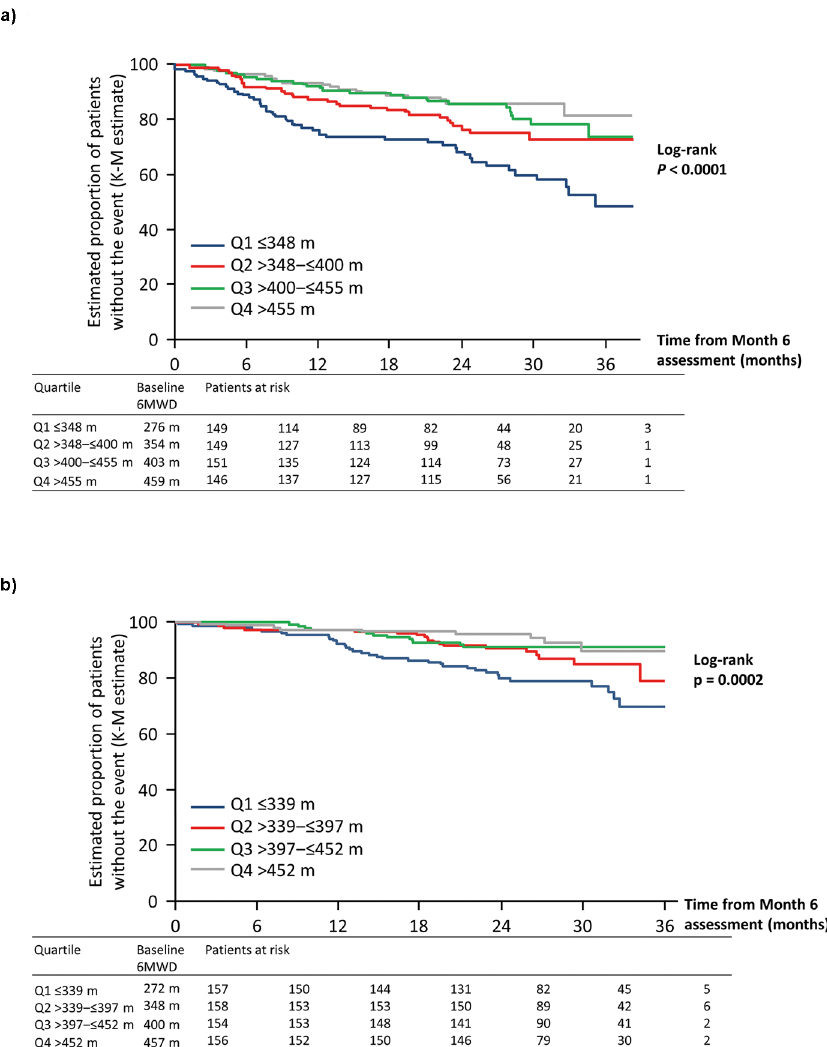
Fig 2. Association between absolute 6MWD quartiles at Month 6 and long-term outcomes in patients with PAH: A. PAH-related death or hospitalization up to end of treatment; B. All-cause death up to end of study. 6MWD, six-minute walk distance; K-M, Kaplan–Meier; PAH, pulmonary arterial hypertension.